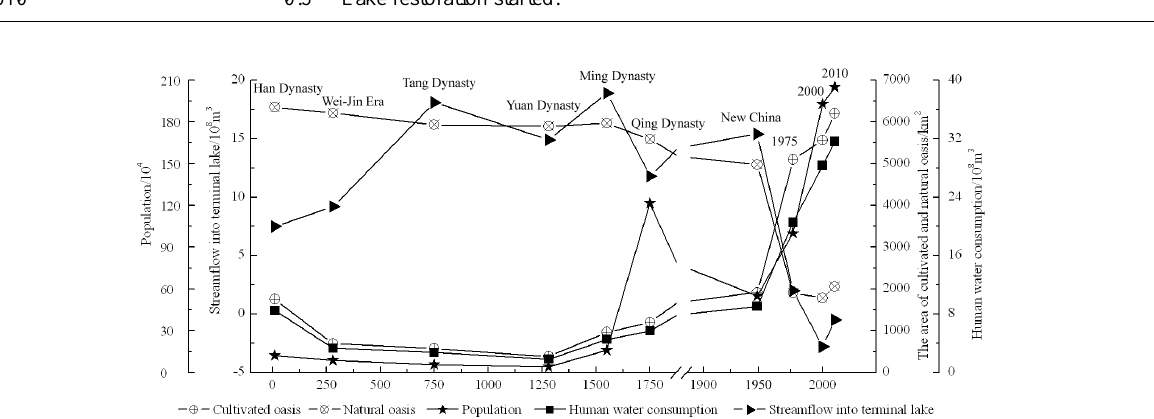
Figure 5. Changes in elements of the reconstructed catchment water balance over the past 2000 years in the midstream and downstream